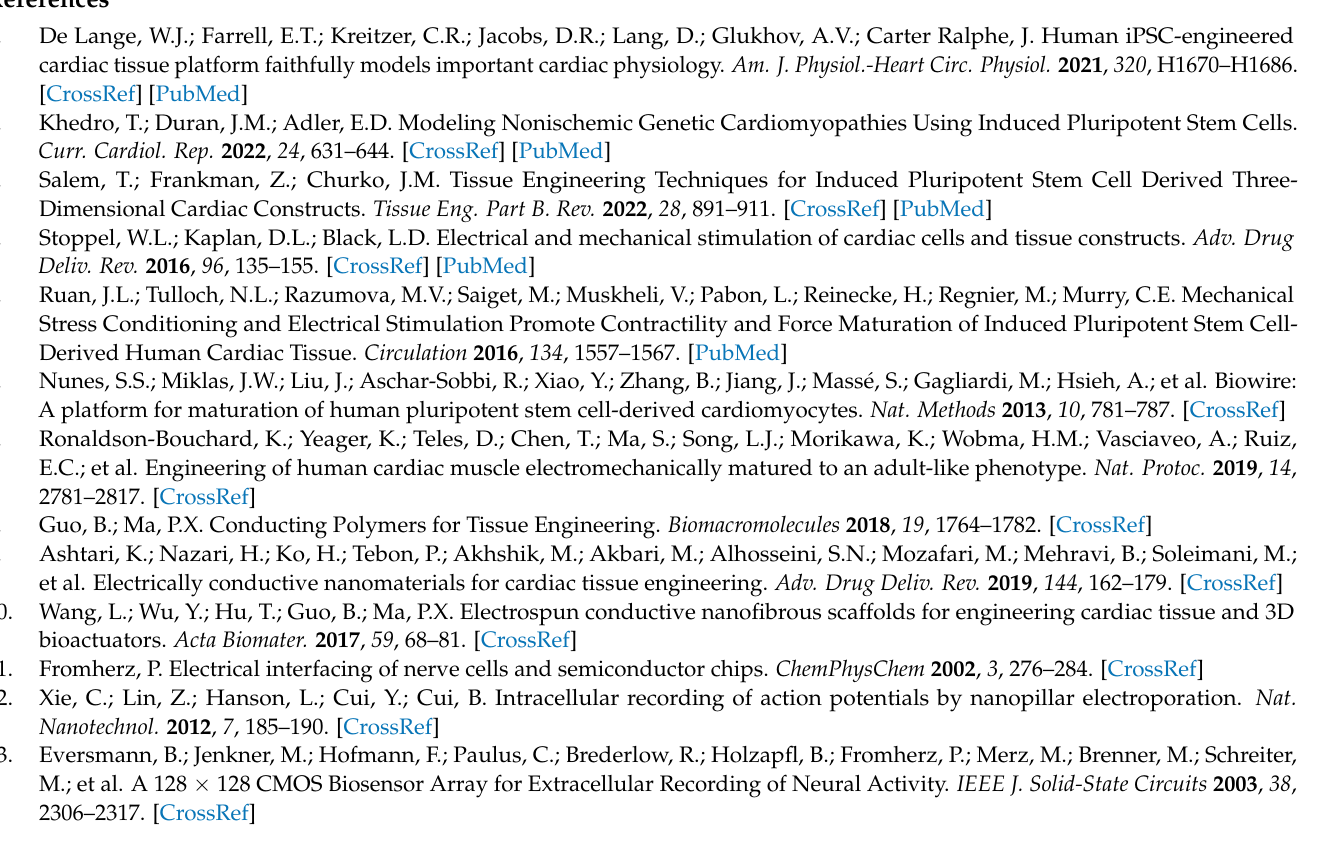
Table S2: Cardiac stromal cell viability 24 h after incubation with cell culture media incubated with ZnO-NanoWires coated Si wafer (ZnO-NWs 1 h and 3.5 h) or ultra-thin ZnO film on Si wafer